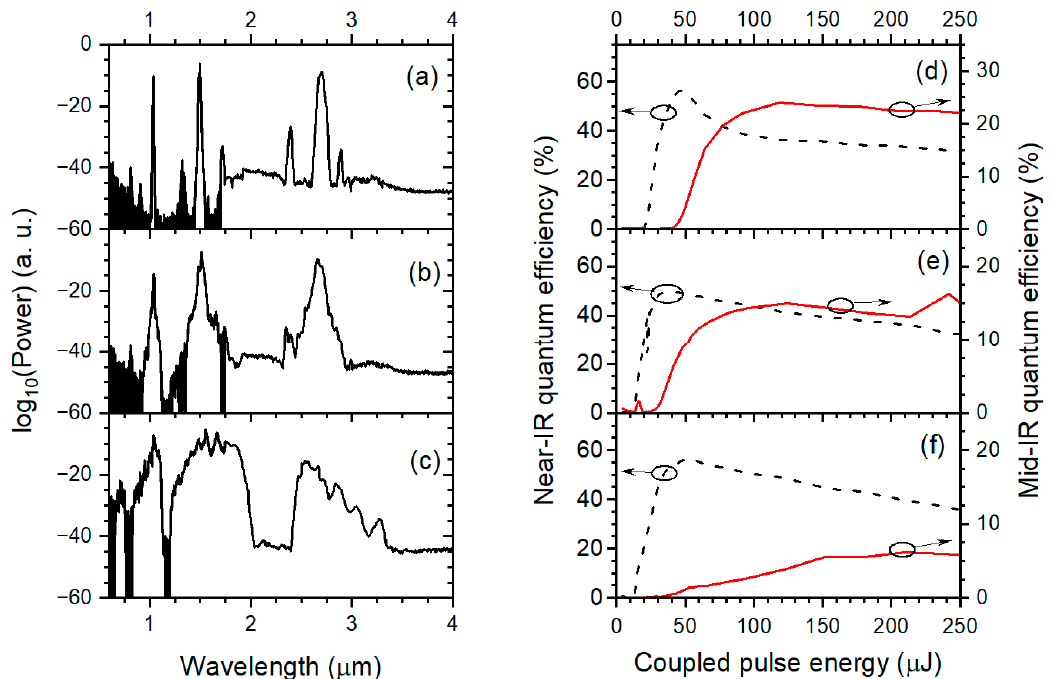
Figure 3. The output spectra at pump pulse duration of 12 ps ( a ), 3 ps ( b ), and 1 ps ( c ). Quantum conversion efficiency of the pump into 1.1–1.9 μ m band (black dashed curves) and to wavelength range above 1.9 μ m (red solid curves) at pump pulse duration of 12 ps ( d ), 3 ps ( e ), and 1 ps ( f ). The pressure of D 2 was 5 atm.